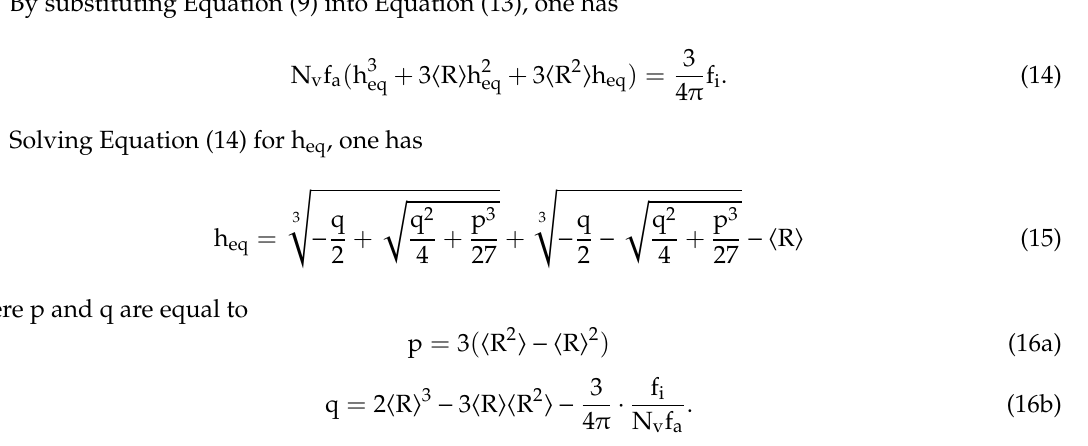
ff ect of interfacial transition zone (ITZ) thickness on h Figure 2. Effect of interfacial transition zone (ITZ) thickness on h eq /h. Figure 2. E